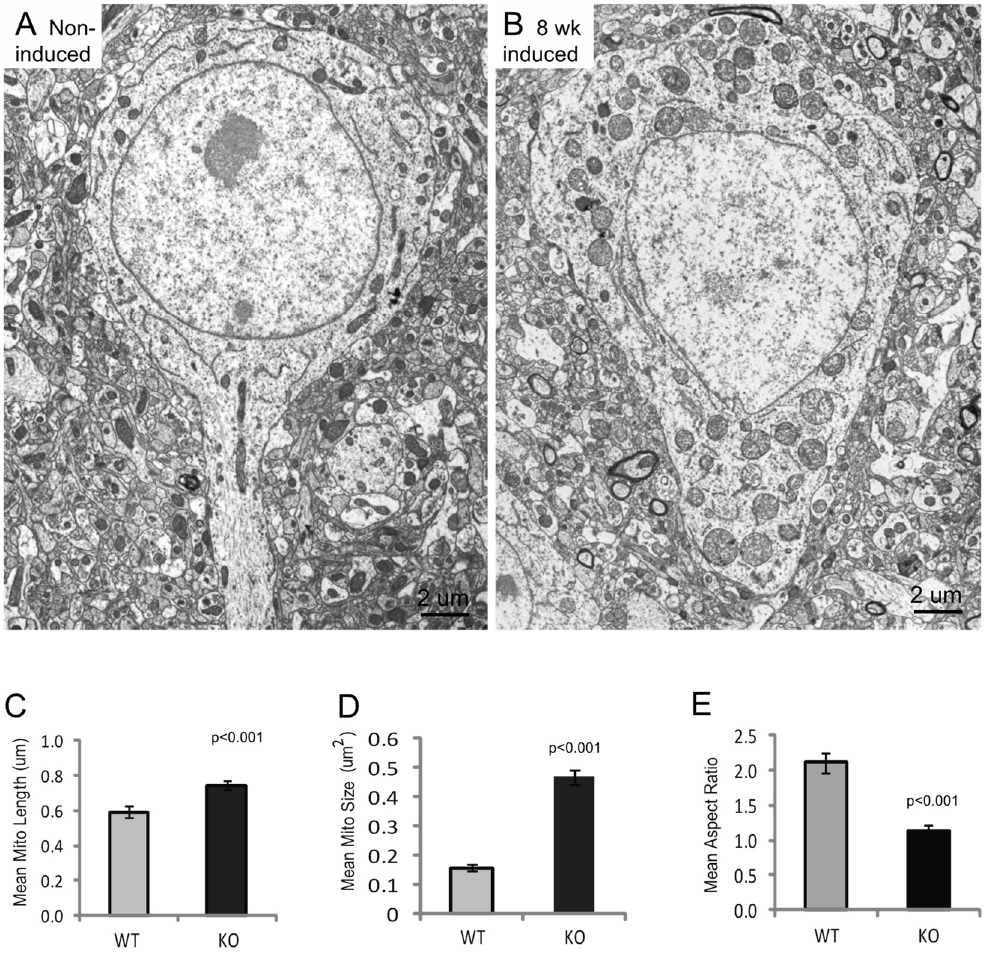
Figure 3. Loss of Mfn2 results in mitochondria ultrastructural abnormalities. Electron micrographs from 8 weeks post-induction mice show that the mitochondria in Mfn2 iKO neurons appear swollen and enlarged ( B ) compared with neurons from non-induced mice ( A ). Quantification of all mitochondria in 8 neurons from at 8 weeks post-induction and 14 neurons from non-induced control neurons found that the mitochondria were approximately 25% longer ( C ) but about threefold larger overall ( D ). Measuring the aspect ratios (the ratio of length / width as a measure of roundness) determined that the mitochondria from normal mice had many typical long and thin mitochondria, though all mitochondria in the Mfn2KO mice were very round, with a mean aspect ratio near 1 ( E ). WT (Wild type), KO (Mfn2 iKO).